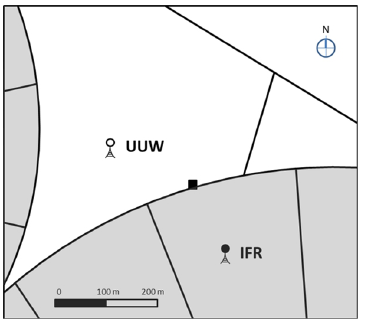
Figure 1. Schematic of paddocks and instrument layout on a com- mercial dairy farm on the Canterbury Plains of New Zealand. Ar- eas of irrigated, fertilised and rotationally grazed pasture (IFR) are shaded in grey. An area of unirrigated, unfertilised and winter- grazed pasture (UUW) is wedged between two pivot-irrigation cir- cles. The measurement sites in the IFR and UUW paddocks are in- dicated by mast symbols. An instrument hut was situated on the boundary between the two paddocks (filled square).